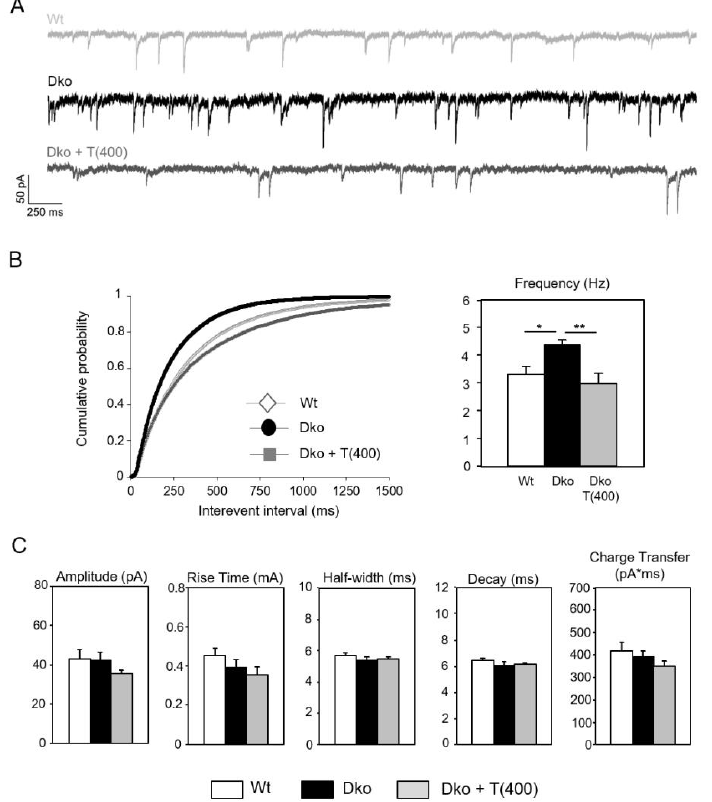
Figure 5. Deletion of Mct8/Oatp1c1 modulates GABAergic transmission in the cortex. Electrophysiological parameters were recorded on coronal forebrain sections using patch-clamp technique. ( A ) Representative traces of mIPSCs of Wt, Dko, and Dko + T (400) recorded from pyramidal neurons of the somatosensory cortex. ( B ) Cumulative plot and bar chart of mIPSC frequencies demonstrating a significant increase in Dko animals that can be rescued by application of Triac for 3 weeks. ( C ) Amplitude, rise time, half-width, time constant of decay, and transported electric charges are not modified in neurons from Dko animals. n = 17 – 18. *, p < 0.05; **, p < 0.01.